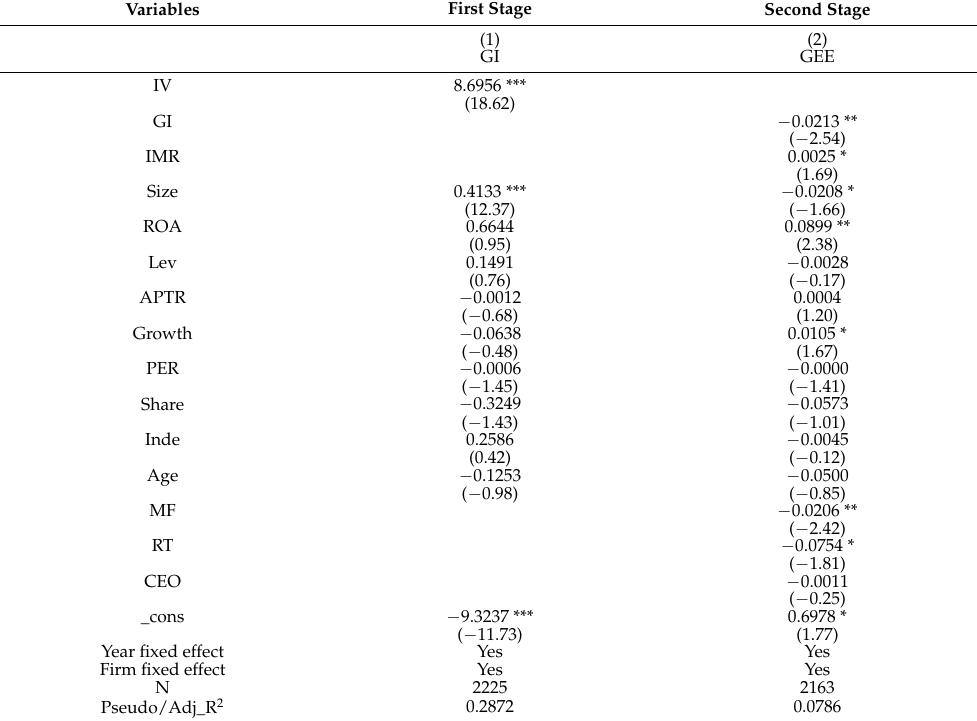
Table A11. Green innovation and green economic efficiency: Heckman two-stage (Full version of column (3)–(4) of Table